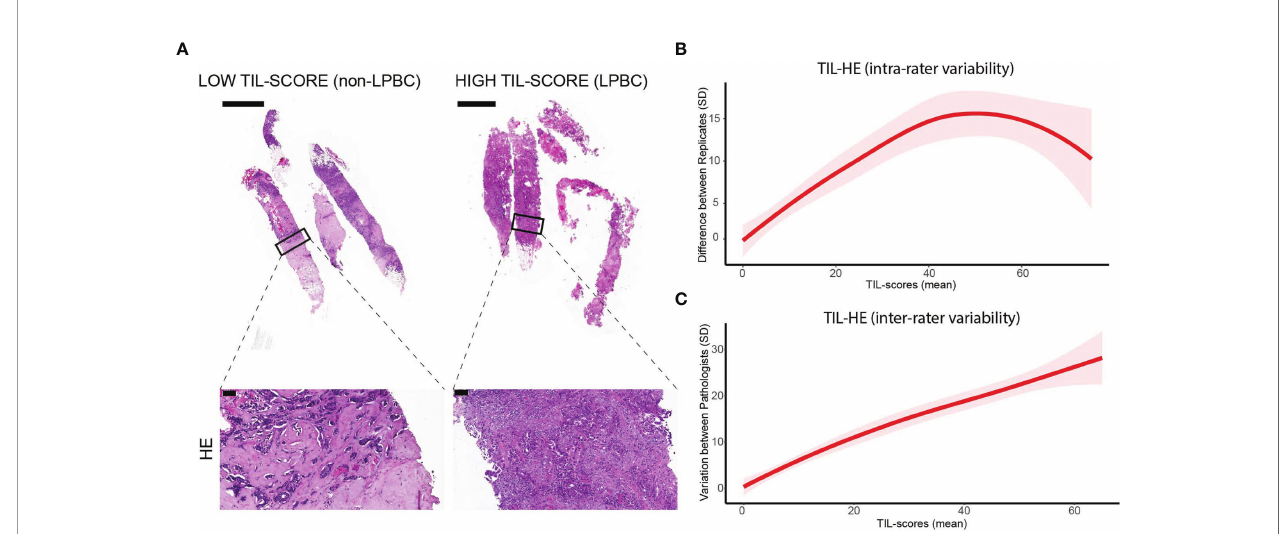
FIGURE 1 | Intra- and interrater variability of TIL scores determined on HE-stained tissue sections. (A) HE staining of breast cancer tissue sections. Scale bars: 2 and 100 µm (respectively upper and lower panels). (B) Graph showing intrarater variability. (C) Graph showing interrater variability. Data information: 37 biopsies were stained with HE and scored twice with a washout period of 3 days by three independent pathologists. In (B , C) , data are presented as mean ± con fi dence interval of